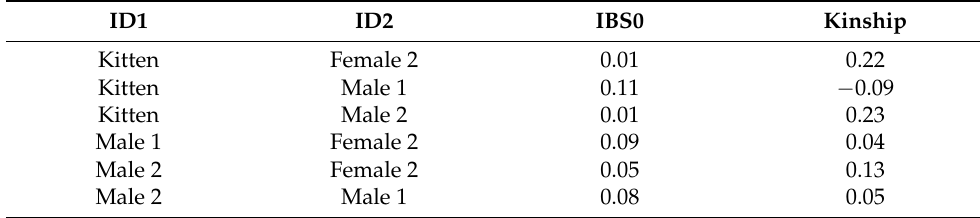
Table 3. Genetic relatedness based on 4,640,102 single-nucleotide polymorphisms.